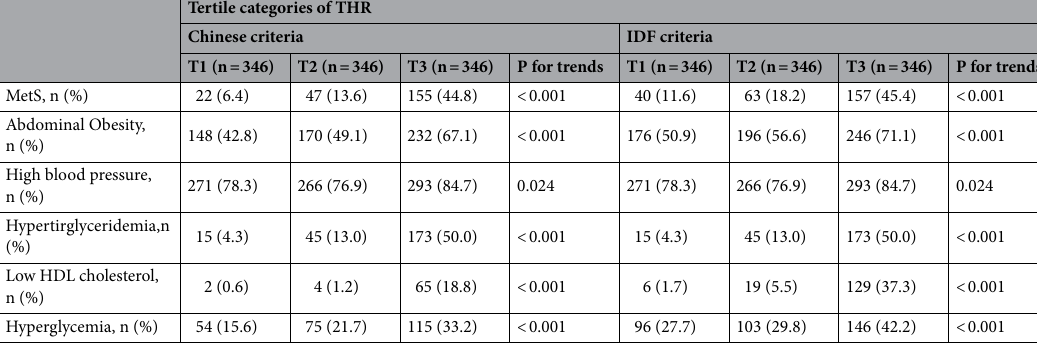
Table 2. Estimated prevalence of metabolic syndrome and its components. Data are expressed as number (percentage). HDL high-density lipoprotein, IDF international diabetes federation, MetS metabolic syndrome, THR total and high density lipoprotein cholesterol ratio. The cut-off values of THR are 2.72 and 3.50.